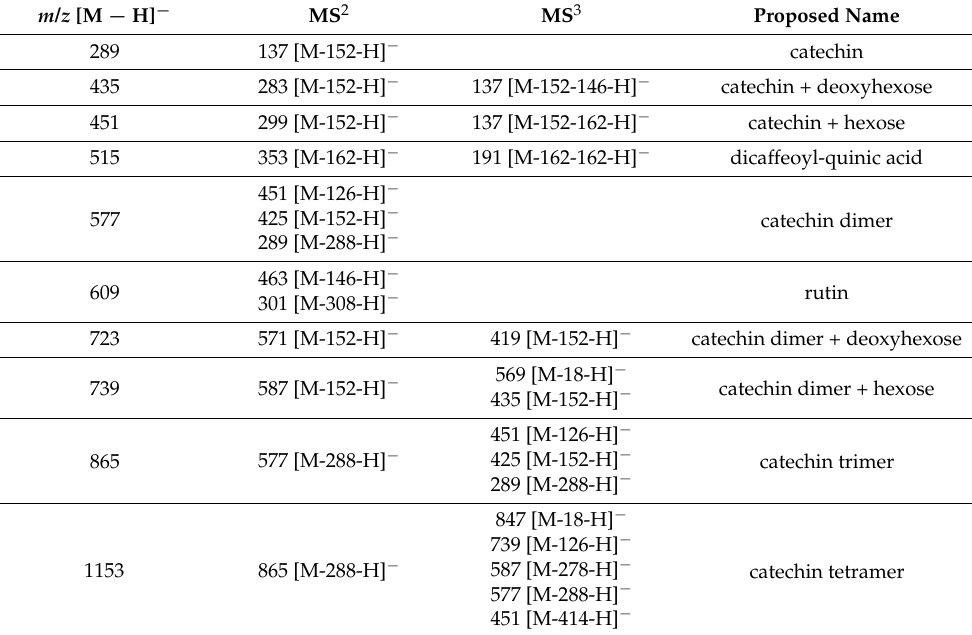
Figure 2. First-order mass spectrum of AERM evaluated by negative mode ionization. n = number of catechins units; ◾ catechin derivatives; ● deoxyhex-catechin derivatives; ◊ hexose-catechin derivatives. Table 1. m / z [M − H] − ion, MS n fragments of the compounds obtained by FIA-ESI-IT-MS/MS of the AERM.